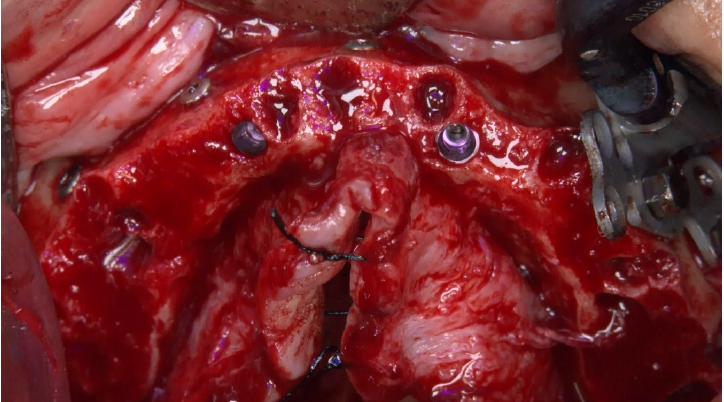
Figure 14. Perioperative photograph immediately after insertion of the implants using an All-on-4 concept design for rehabilitation of the edentulous maxilla.